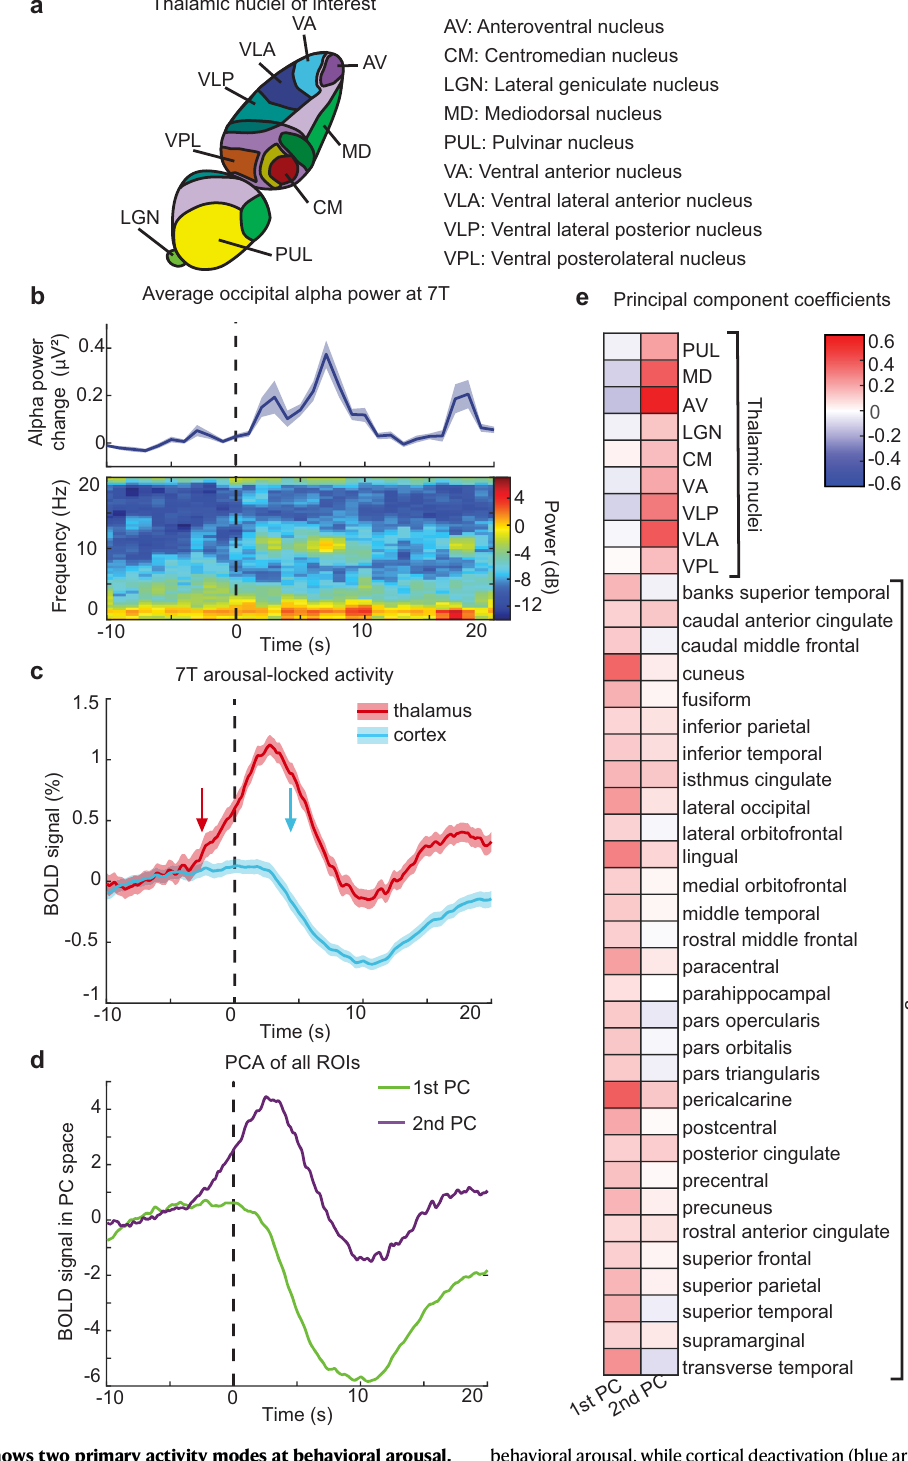
behavioralarousal,whilecorticaldeactivation(bluearrow)follows( n =13subjects, 99arousals).Shadingisstandarderror. d Aprincipalcomponentanalysisofallnine thalamic regions and 30 cortical regions reveals two primary modes of activity in the thalamus and cortex: one which increases before arousal and one which decreases after arousal. e The fi rst principalcomponent ismoreheavilyin fl uenced by cortical regions, and the second is in fl uenced primarily by thalamic regions, demonstrating segregationofthalamicand cortical activityduring arousal.Source data are provided in the “ Fig. 3 Source Data ” fi le.